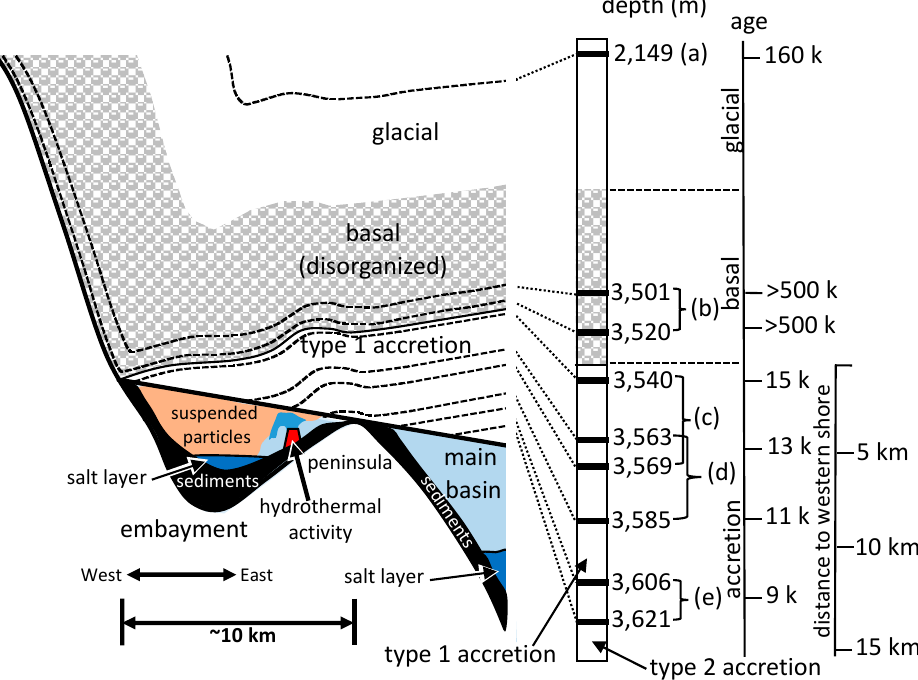
Figure 1. Profile model of the portion of Lake Vostok (left half) that is the focus of this research, based on the data from this research and elsewhere [1,2]. Ice core sections used in this research are shown (black bars, middle right), as part of the Vostok ice core. For both parts of the figure, the upper white portions are glacial ice (3310 m) that is in layers (right). The next 228 m is basal ice (shaded with gray ellipses), type 1 accretion ice (shaded in solid gray), and type 2 accretion ice (white). The ice core samples used for this research are listed (a–e). Approximate ages of the ice and approximate distances from the western shore (according to maps from ref. [1,2,6,7]) are on the far right. Possible hydrothermal activity is indicated on the eastern side of the embayment (red trapezoid).